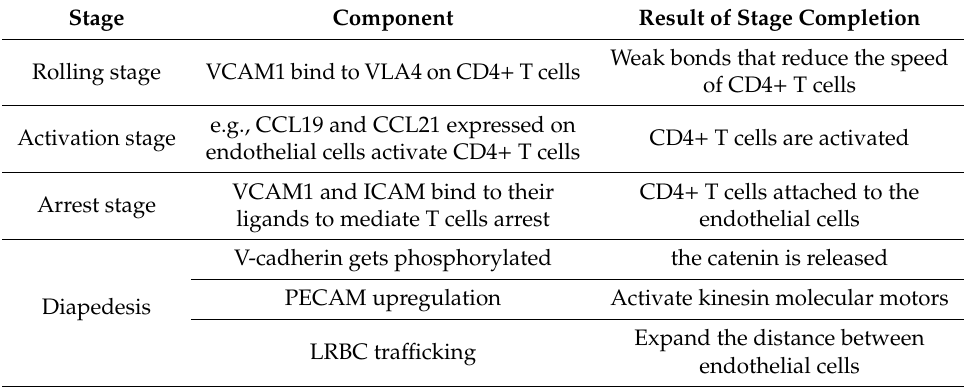
Table 3. Various stages of CD4 + T cells infiltration of the